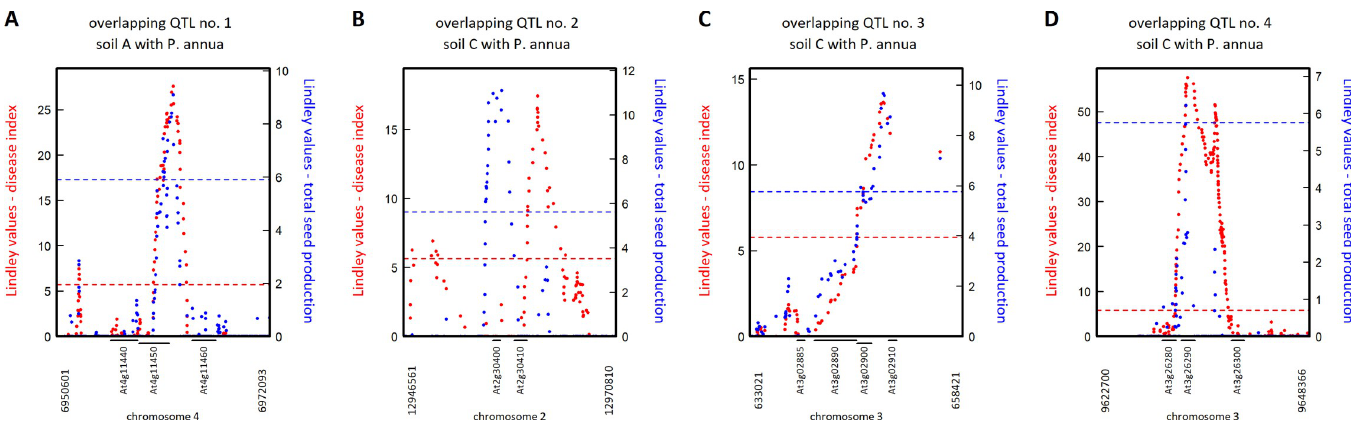
Fig 6. Zoom spanning the four genomic regions containing candidate genes common between disease index and total seed production. (A) Overlapping QTL between disease index and total seed production on soil A in presence of P . annua . (B-D) Overlapping QTLs between disease index and total seed production on soil C in presence of P . annua . Red and blue dots correspond to Lindley values for disease index and total seed production, respectively. The red and blue dashed lines indicate the corresponding chromosome-wide significance threshold for disease index and total seed production, respectively. Vertical numbers (expressed in bp) at the bottom of each panel correspond to the physical positions of the QTL